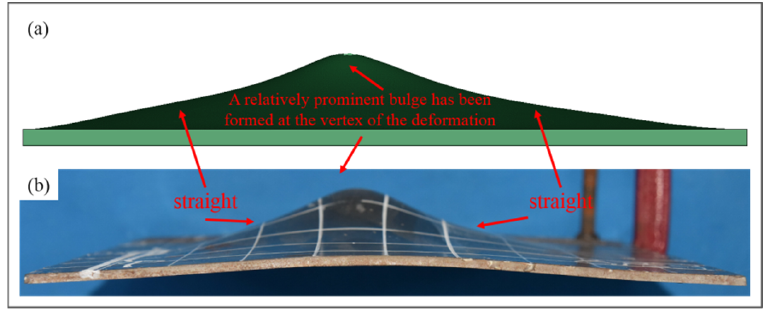
Figure 8. Comparison of back plate damage morphology in Experiment 4.